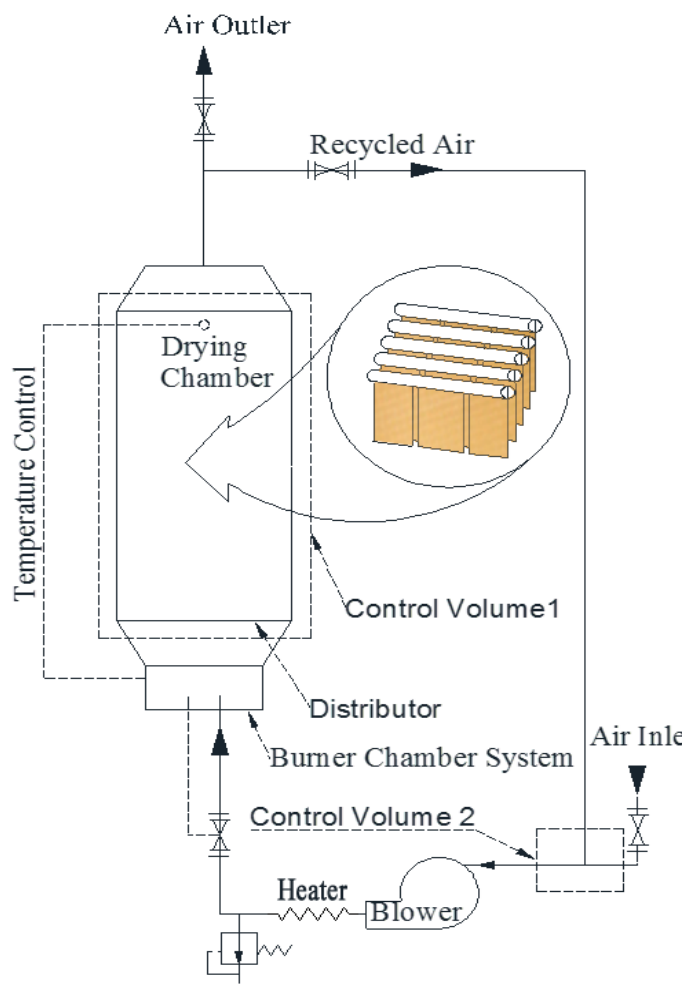
Figure 1. Schematic diagram of the drying system.